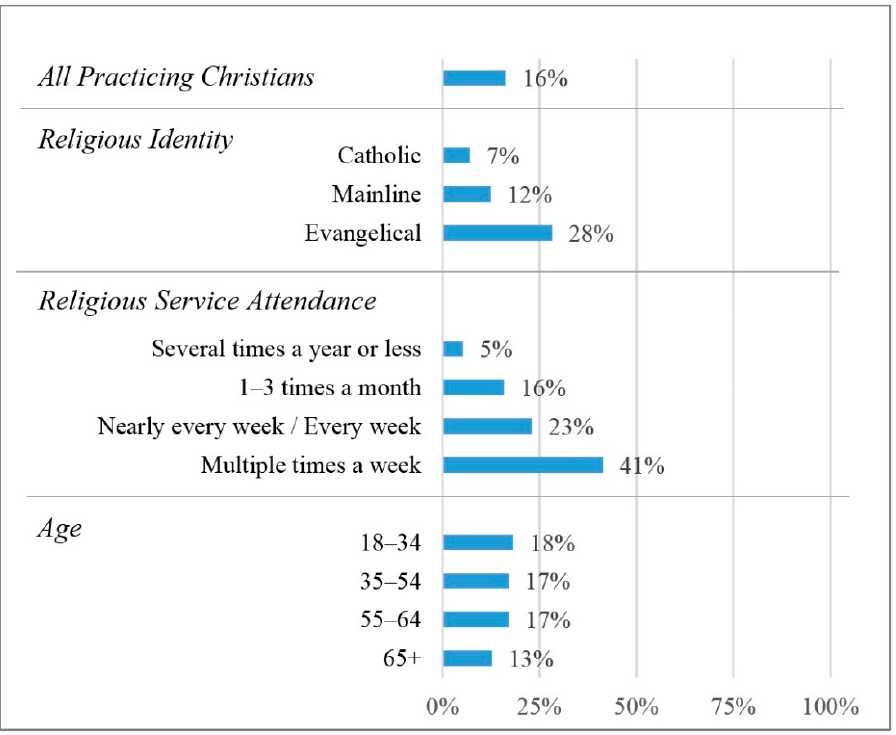
Figure 4. % of people who say their faith leader often or very often discusses how they should behave at work (overall and by subgroup).